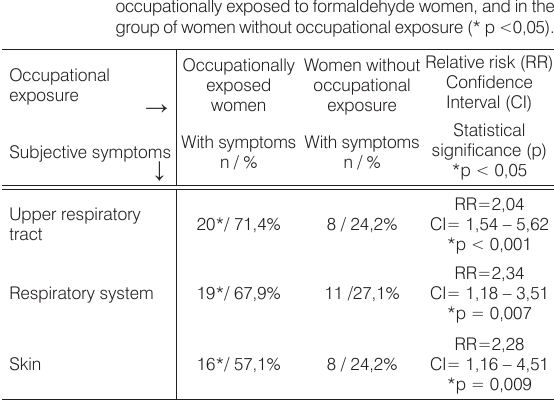
Table 4. Distribution of subjective symptoms in the group of occupationally exposed to formaldehyde women, and in the group of women without occupational exposure (* p